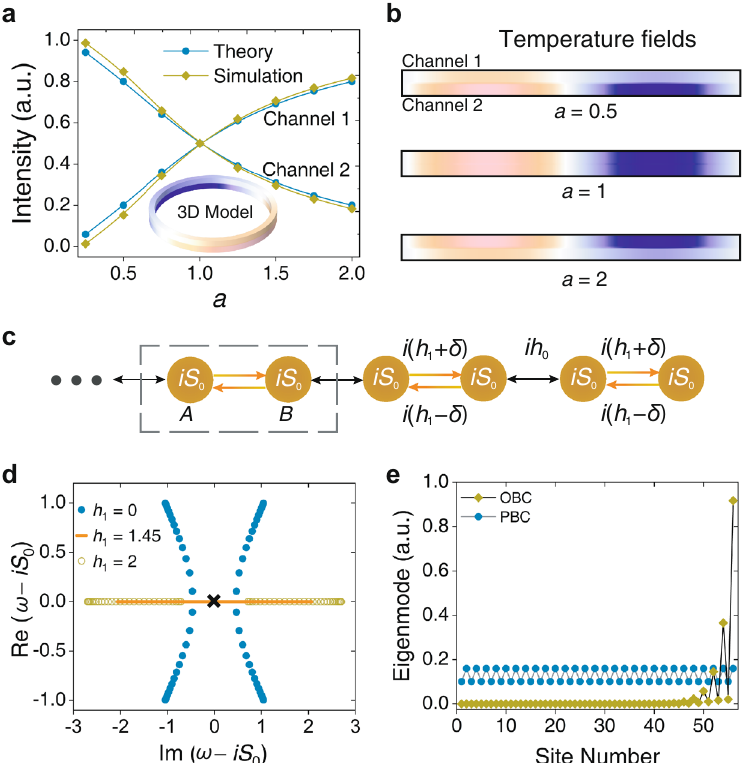
Fig. 2 Asymmetric coupling model and diffusive skin effect. a , b Temperature fi elds intensities and distributions of two directly coupled channels versus the asymmetric factor a . Note that at a = 1, the temperature fi eld distribution is symmetric, the insert shows the 3D model at a = 0.5. c The diffusive tight- binding Su-Schrieffer-Heeger (SSH) model for open boundary condition (OBC) with asymmetric intracell coupling i ð h 1 ± δ Þ and symmetric intercell coupling ih iS fi ed decay rate on each site. d Spectra in the complex plane at coupling parameters h 0 , 0 is the uni e Amplitude distributions of eigenstates for OBC and periodic boundary condition (PBC), at h 1 ¼ 1 : 45. The unitcell number is